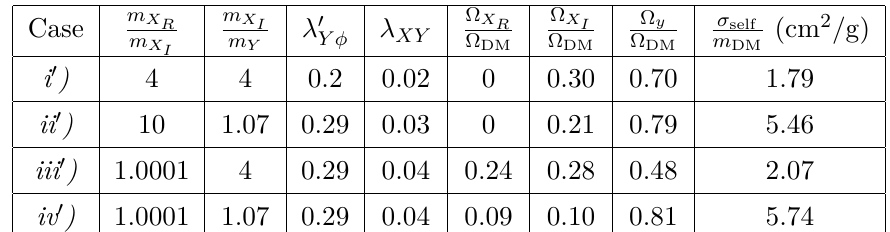
Table 3 . Input parameters with non-zero λ XY and outcomes of DM relics and the self-scattering cross sections. The rest of the input parameters are chosen as follows: m